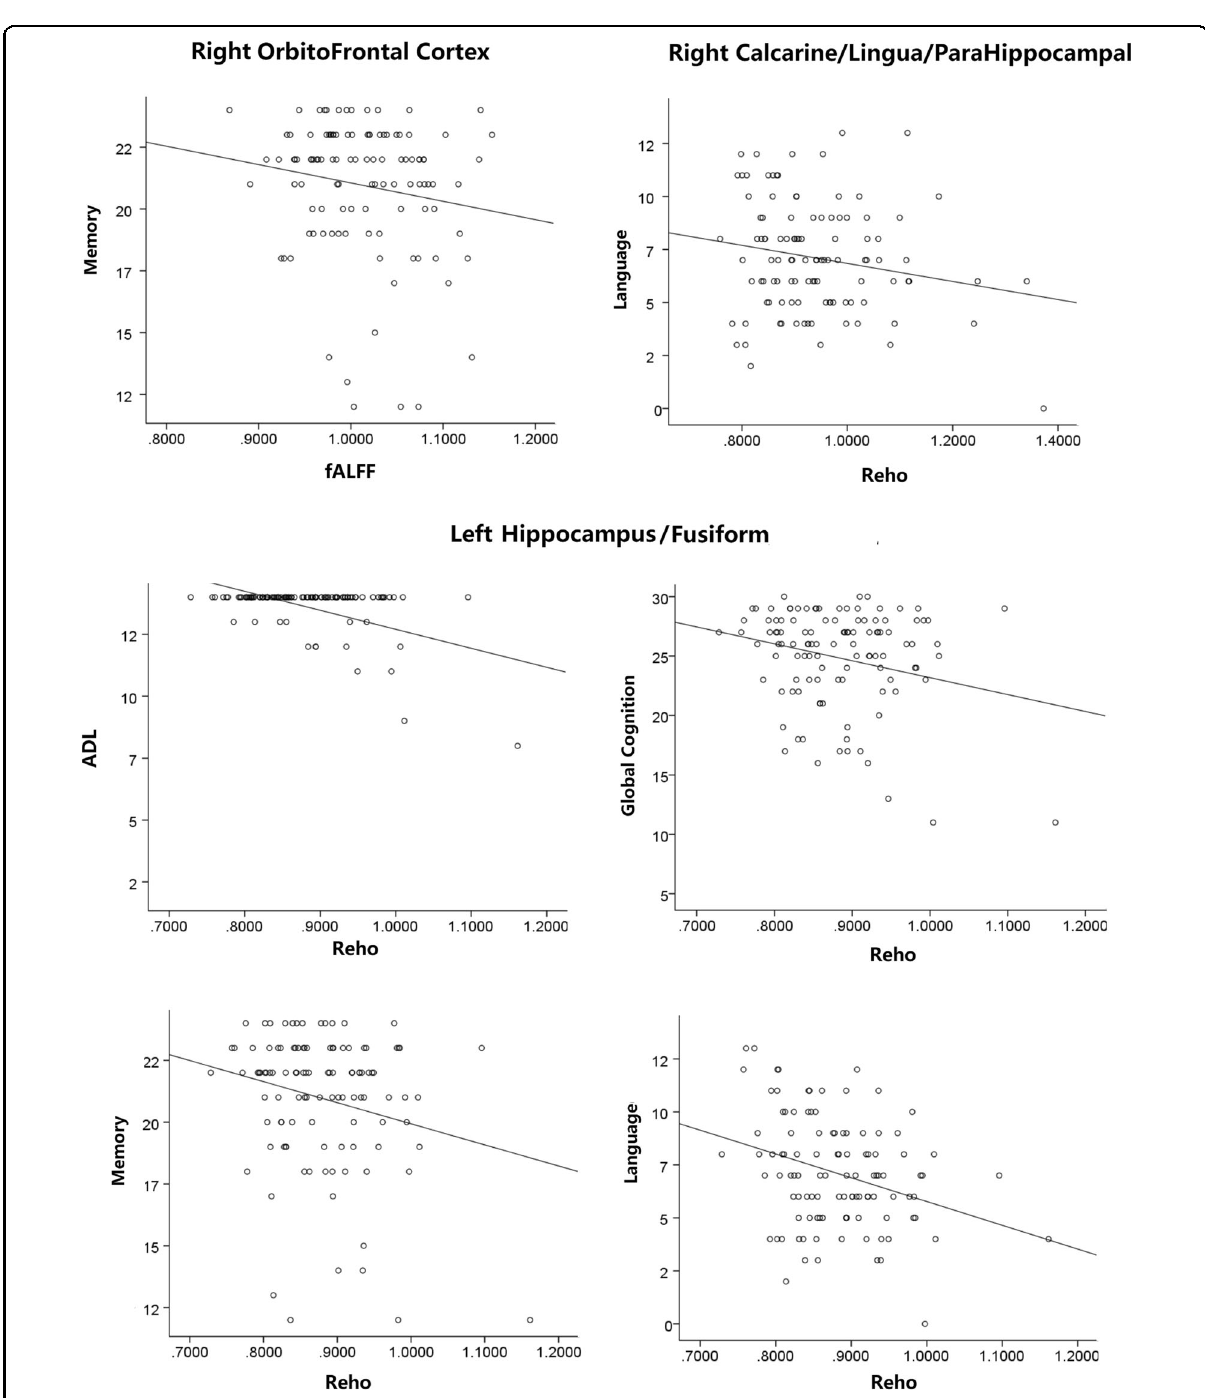
Fig. 3 Correlations between cognitive function and brain activities in additive regions across all subjects. ADL, Activities of Daily Living Scale; fALFF, fractional amplitude of low-frequency fl uctuation; ReHo, regional